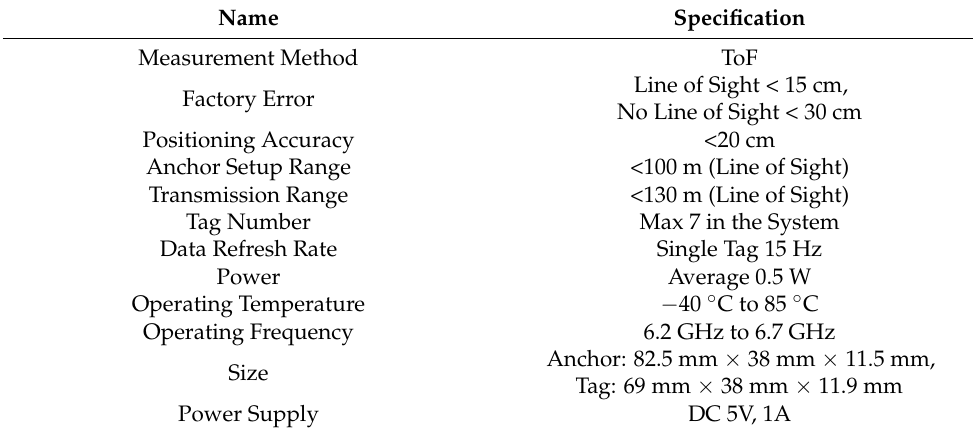
Figure 2. Three UWB Anchors and one UWB tag. Table 1. UWB anchor and tag